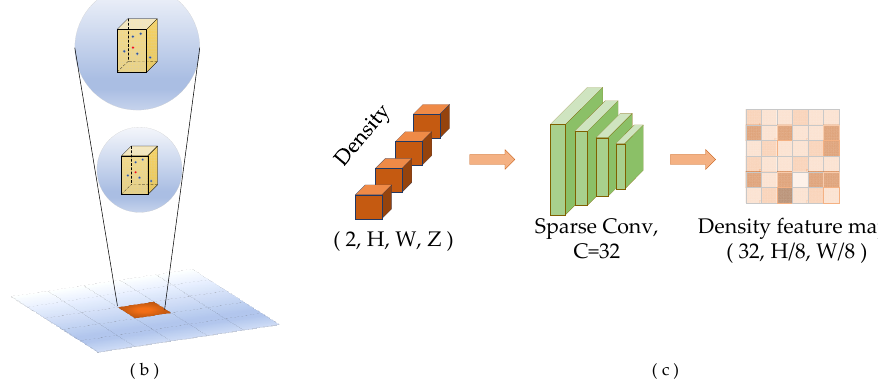
Figure 4. Diagram of VDA. ( a ) Relationship between center point and points in other voxels. ( b ) Mapping of multi-scale density information on BEV map. ( c ) The process of extracting density features.